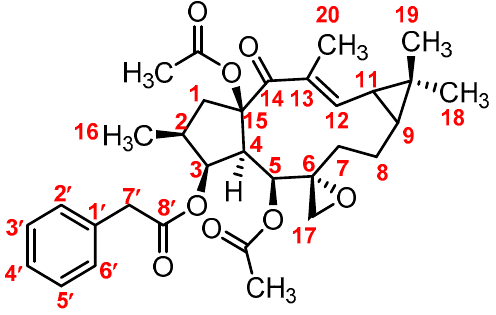
Figure 1. The chemical structure of euphorbiasteroid ( M0 ).